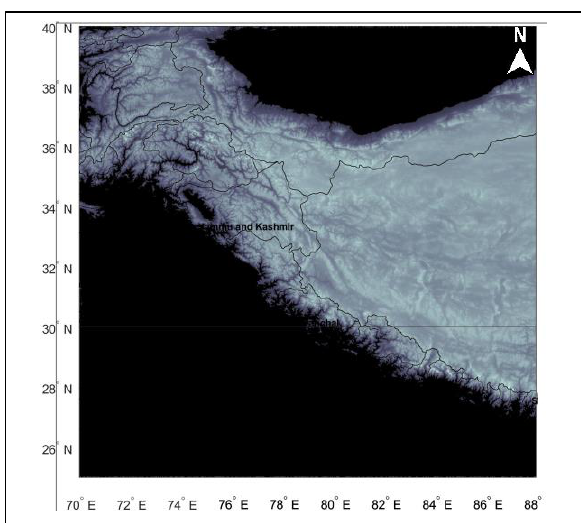
Figure 1: showing Central and Western Himalayan region, the elevation of our study area is equal and greater than 2000